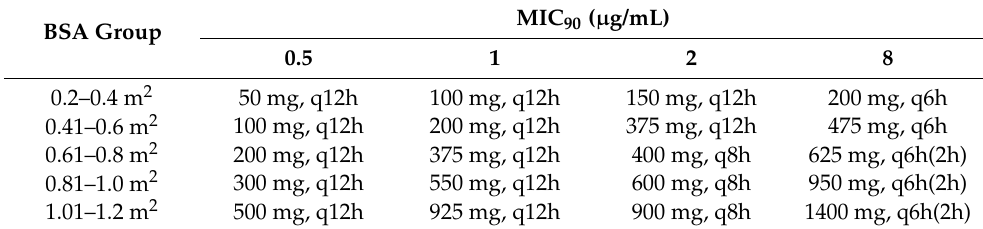
Table 5. Dosing regimen of latamoxef by Monte Carol simulations.